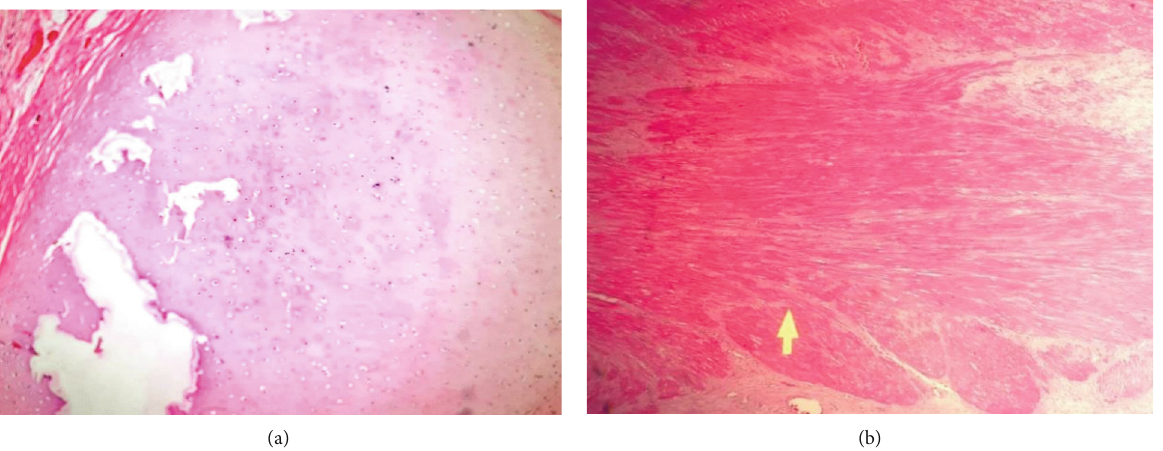
Figure 4: (a) Microscopic section showing well-formed cartilaginous tissue (H and E, × 100). (b) Microscopic section showing well-formed skeletal muscle tissues (H and E, ×